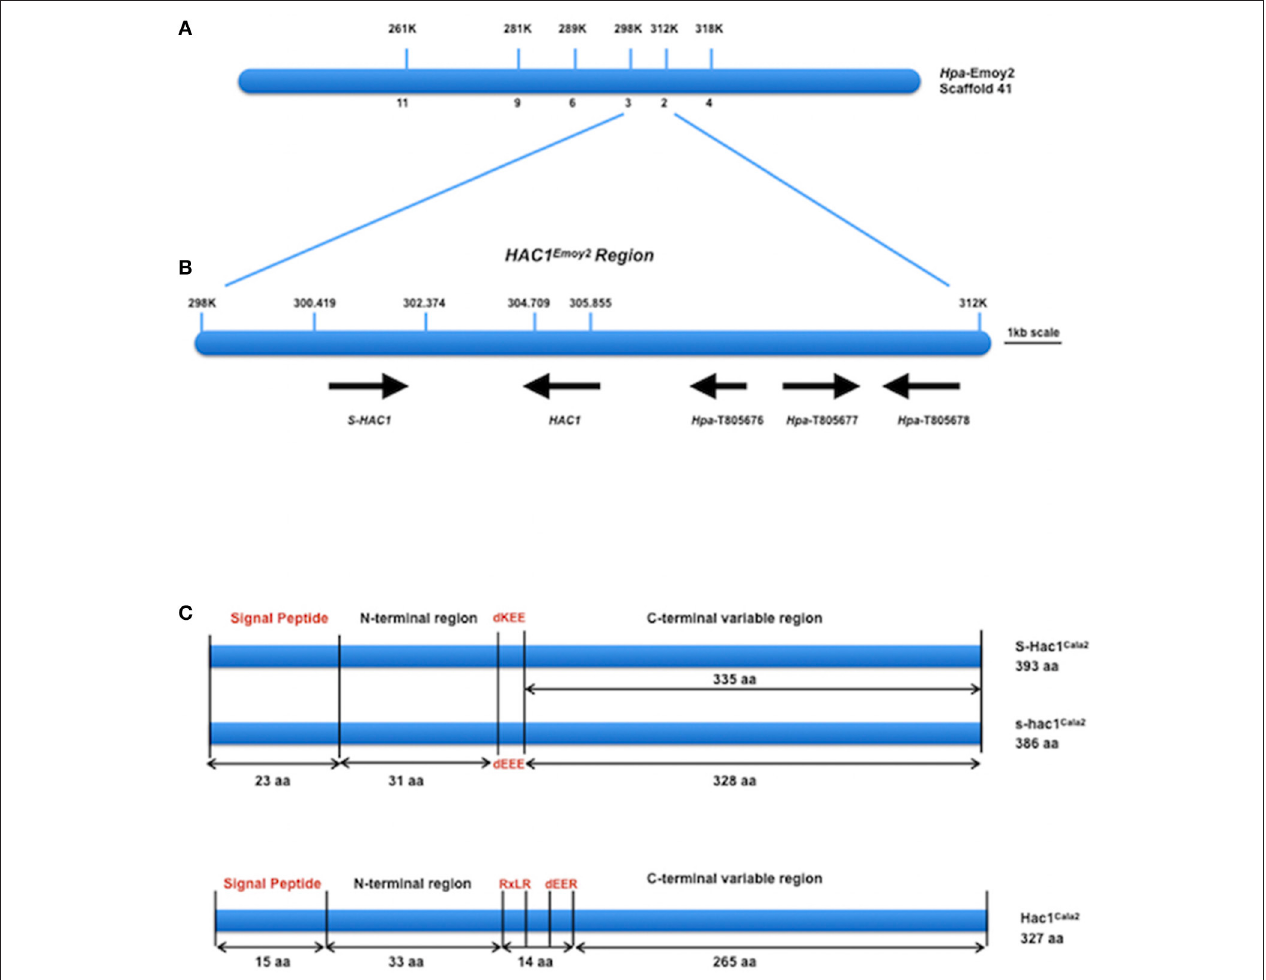
FIGURE 2 | Map-based cloning of HAC1 . (A) Position of molecular markers used to map the HAC1 locus on the reference genome Emoy2 Scaffold 41. Numbers below the bar indicate the number of recombinants in 190 CaNo F 2 individuals. (B) The genes where HAC1 and S-HAC1 are embedded in the locus. Predicted protein sequences of these genes suggest that they encode, S-HAC1 , a secreted unknown protein and heterozygous in Cala2 genome; HAC1 , a secreted unknown protein; Hpa -T805676, an unknown protein; Hpa -T805677, a NAD-dependant epimerase/dehydrase; Hpa -T805678, an actin-like protein. (C) Structures of S-HAC1 Cala2 , s-hac1 Cala2 and HAC1 Cala2 . S-HAC1 Cala2 has an initial signal peptide (1-23aa) and a dKEE motif (55-58aa). s-hac1 Cala2 has an initial signal peptide (1-23aa) and a dEEE motif (55-58aa). Neither S-HAC1 Cala2 nor s-hac1 Cala2 had RxLR motifs. There were several polymorphic sequences between S-HAC1 Cala2 and s-hac1 Cala2 . HAC1 Cala2 has an initial signal peptide (1-15aa), an RxLR (49-52aa) and a dEER (59-62aa) motif. Signal peptide, dKEE/dEEE/dEER and RxLR are indicated in